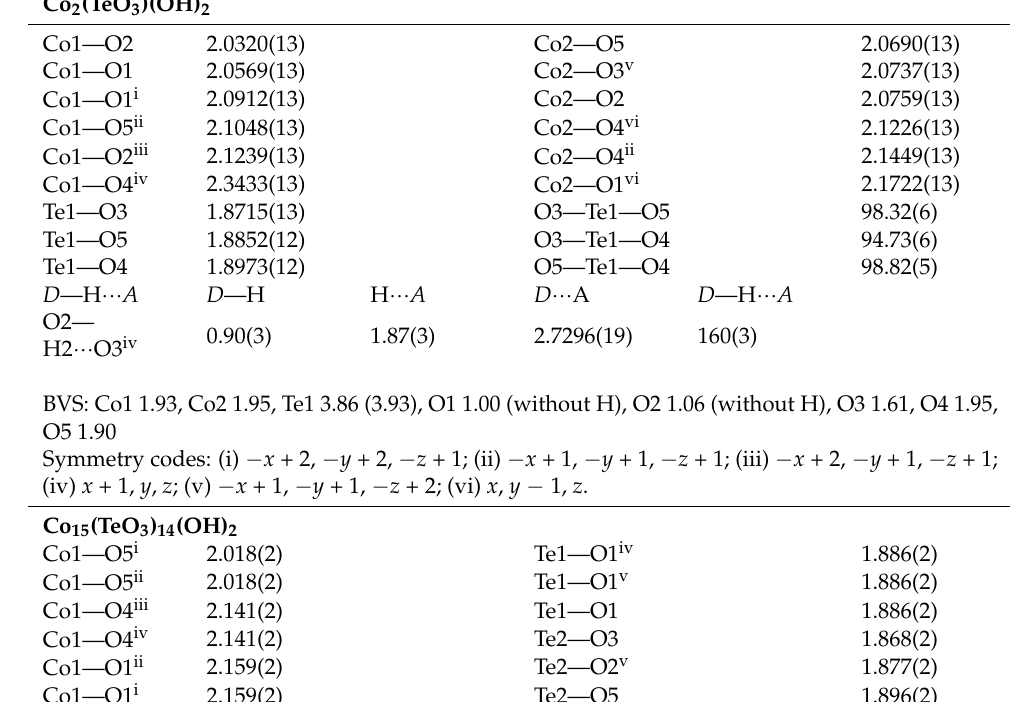
Table 2. Selected bond lengths/Å, angles/ ◦ , details of hydrogen bonding interactions as well as bond valence sums (BVS)/v.u. (values using the revised parameters for Te IV –O bonds [27] in parentheses). Co 2 (TeO 3 )(OH)